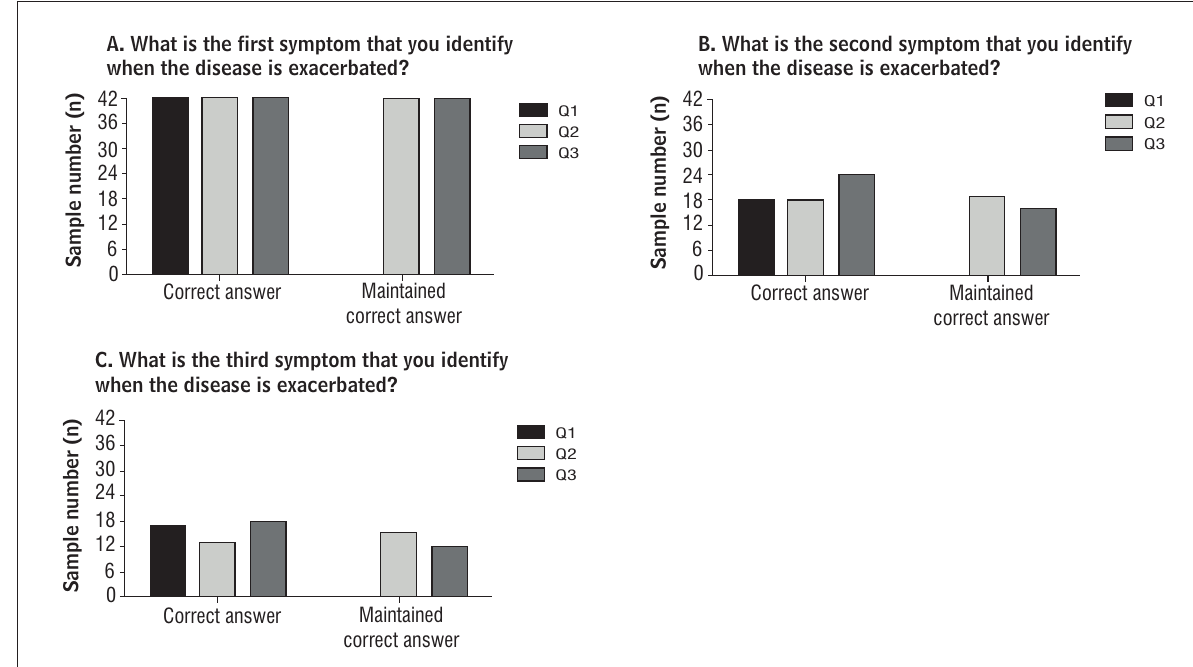
Figure 3 - Patients’ responses regarding the three most common symptoms that precede a COPD exacerbation